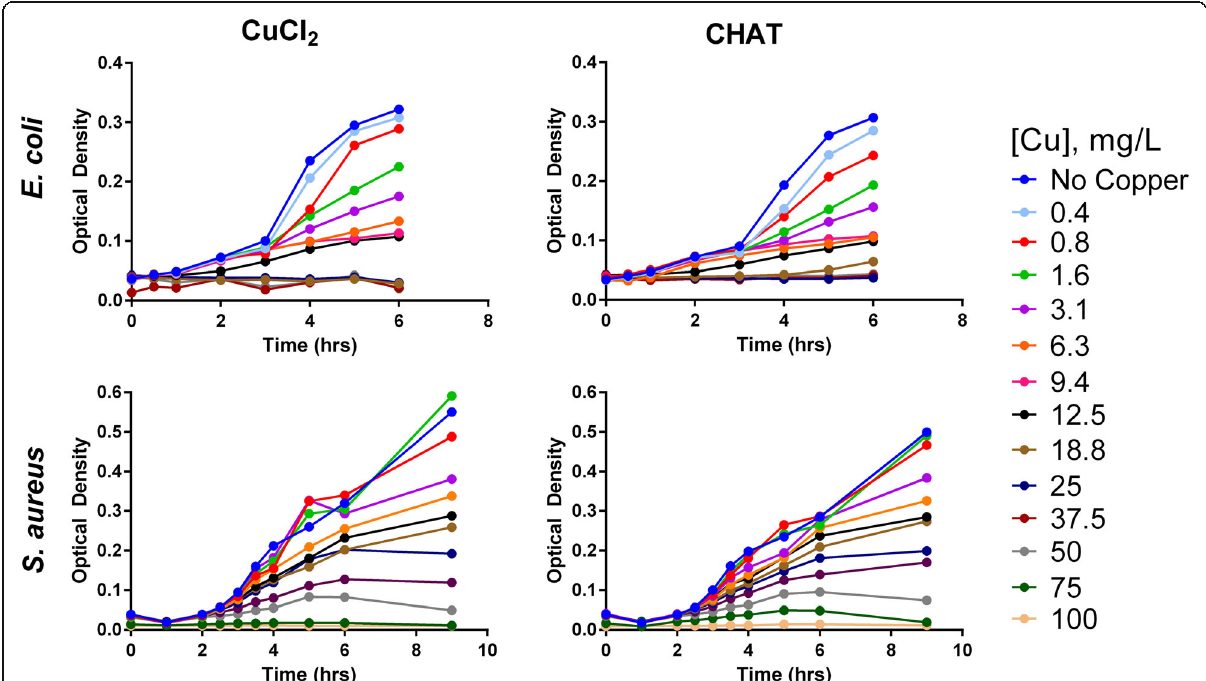
Fig. 2 Escherichia coli (top) and Staphylococcus aureus (bottom) growth curves, represented here as optical density, upon exposure to different concentrations of copper chloride (left) or CHAT (right) in supplemented